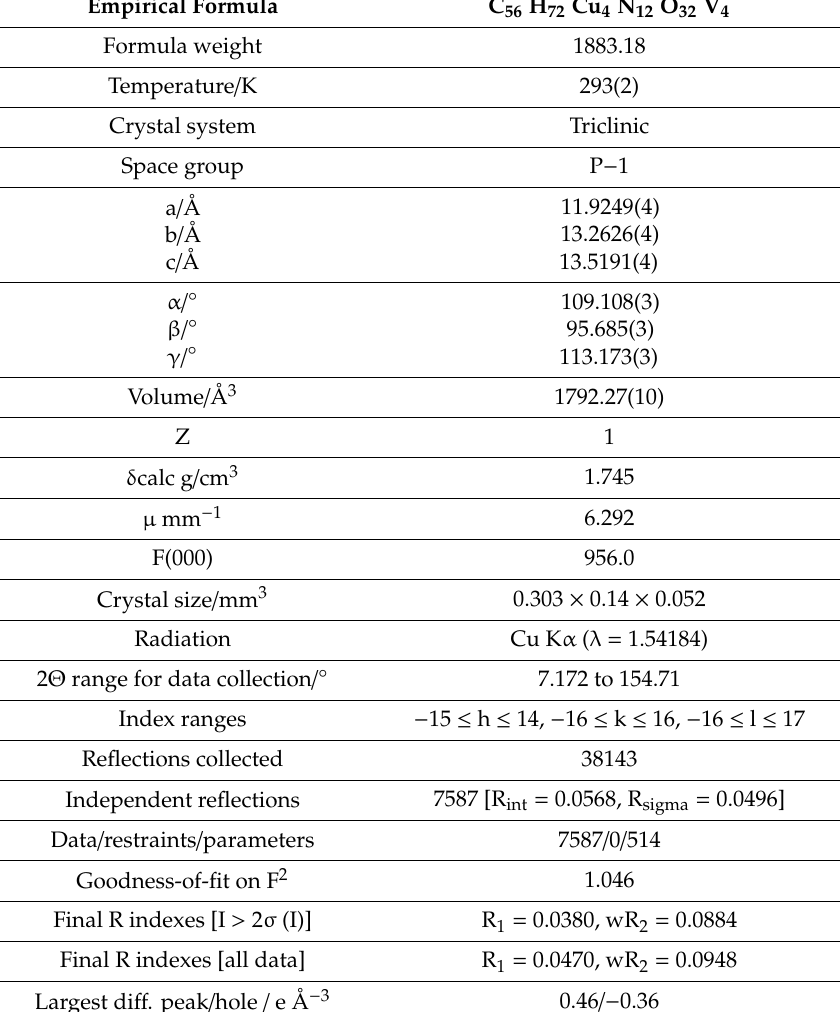
Table 1. Selected crystal data and details of the structure determination for Compound 1